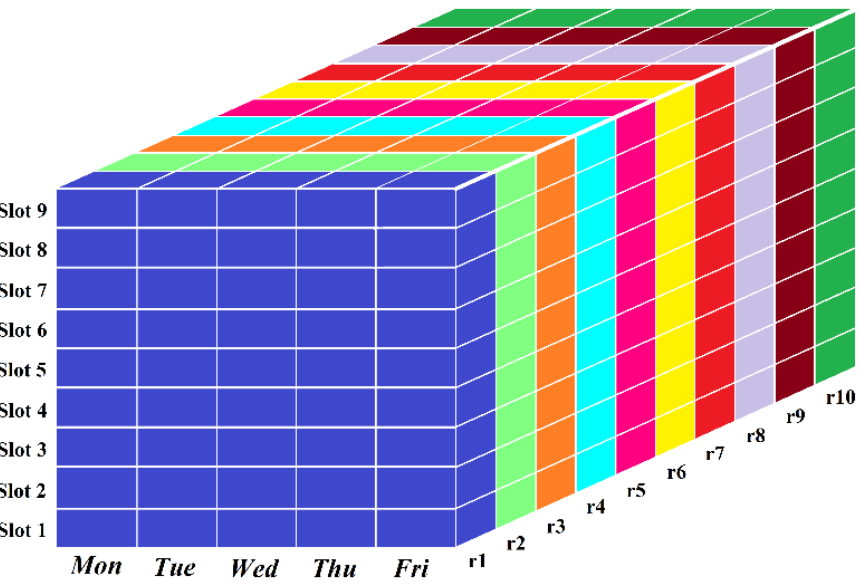
Figure 1. Three-dimensional table of schedules assigned to various rooms ( r 1 to r 10